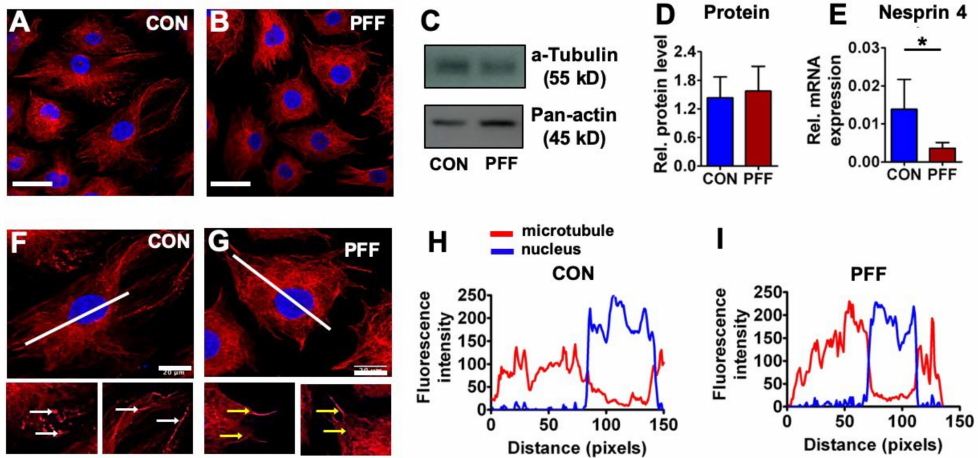
Figure 6. E ff ect of 1 h PFF on α -tubulin protein expression and distribution and nesprin 4 gene expression in MC3T3-E1 osteoblasts. ( A , B ) 2D images of control cells and 1 h PFF-treated cells